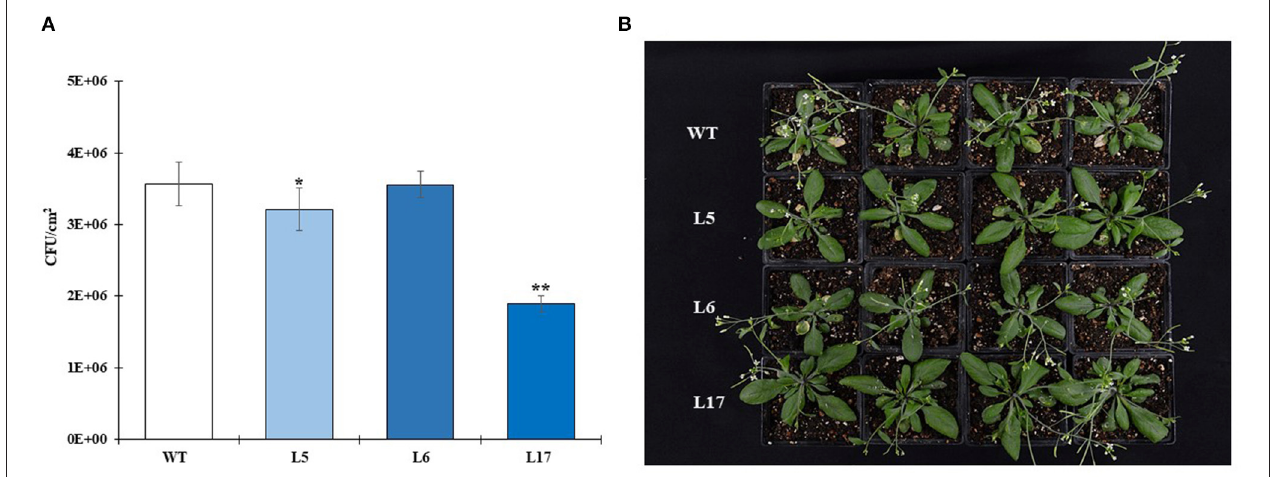
FIGURE 7 | The overexpression of the AhN4L-1 gene in transgenic Arabidopsis thaliana plants confers resistance to bacterial infection in a dose-dependent manner. (A) The growth of Pseudomonas syringae pv. tomato DC3000 was evaluated 72h after inoculation of 20-day old plants with 10 µ L aliquots of a bacterial suspension containing colony forming units/mL (CFUs/mL) to three fully expanded leaves of each plant tested. These were transgenic plant lines (L5, L6, and L17) having significantly different transgene expression dosage and wild-type (WT) untransformed plants. The bars represent the mean number ± SE of CFUs in leaves of five plants for each line examined. Three independent experiments with similar results were performed. Asterisks over the bars denote significant differences at P < 0.05 (*) or P < 0.01 (**) (One-way ANOVA, Tukey-Kramer test). Three independent experiments were performed with similar results. (B) Bacterial infection had a more drastic effect on the growth of WT plants, which also showed increased disease symptoms in the inoculated leaves. The protection to bacterial infection in the transgenic lines was more pronounced in the L17 line having the highest transgene expression